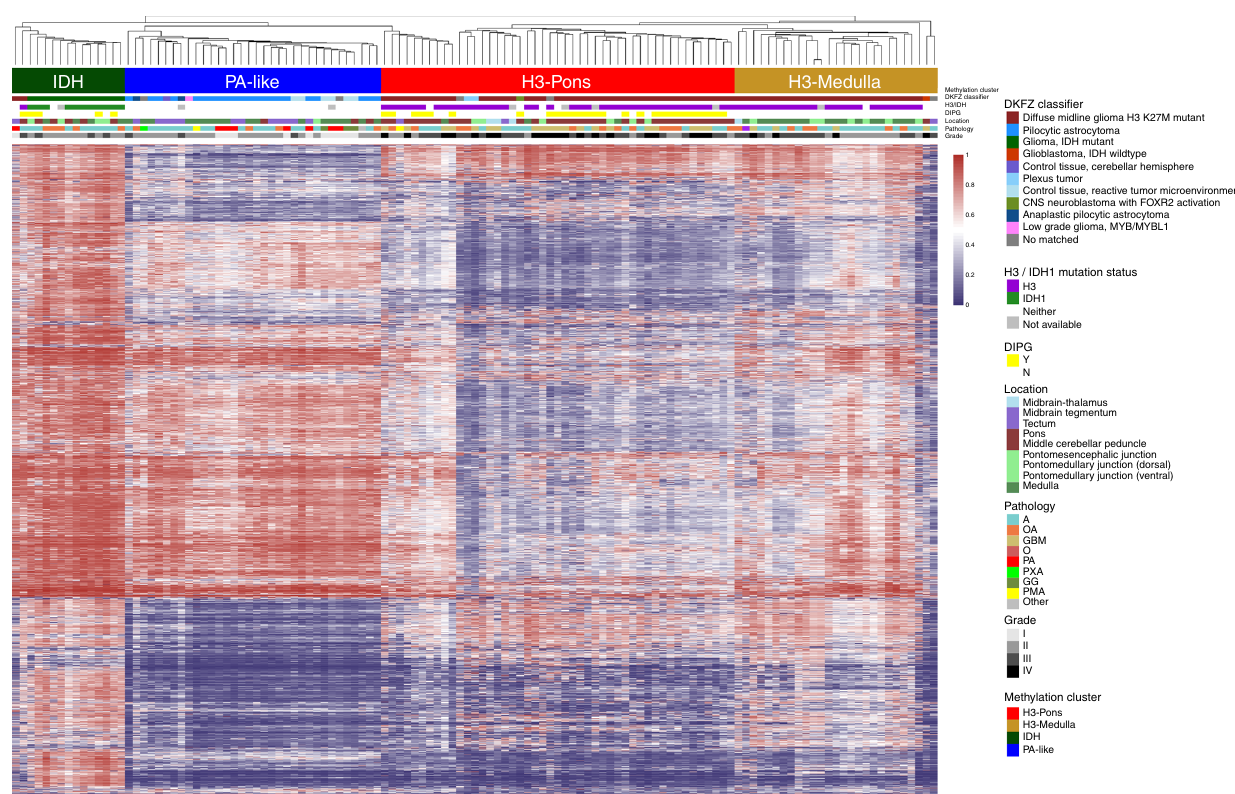
Fig. 1 Hierarchical clustering of methylation status from top 20,000 variable probes. Four distinct clusters could be differentiated: H3-Pons, H3-Medulla, IDH, and PA-like. Color scales indicate average beta values from methylation microarray (ranges from 0 to 1).